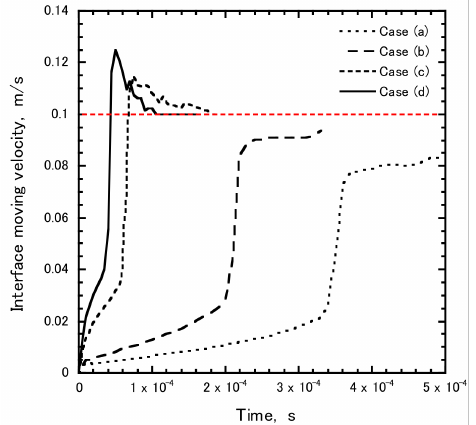
Figure 10. Interface moving velocity with time in case ( a ): 5 × 10 5 K/s and 5 × 10 6 K/m, case ( b ): 1 × 10 6 K/s and 1 × 10 7 K/m, case ( c ): 5 × 10 6 K/s and 5 × 10 7 K/m and case ( d ): 1 × 10 7 K/s and 1 × 10 8 K/m obtained by the non-equilibrium MPFM. The red dashed line indicates the steady